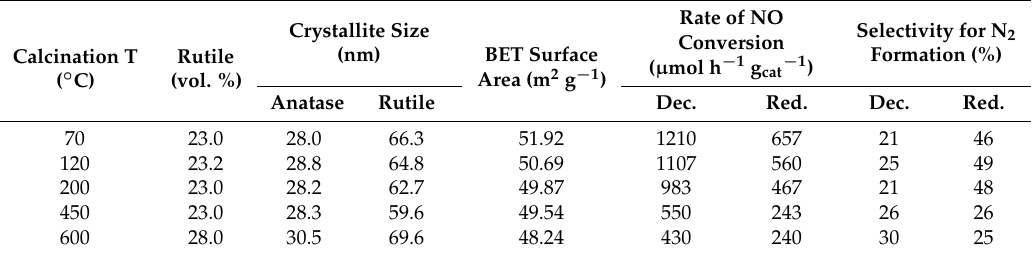
Table 4. Effect of calcination temperatures on the composition and crystallite sizes of P-25 photocatalysts, and of the pretreatment temperature on the rate of NO conversion and selectivity for N 2 formation for NO decomposition and reduction reactions